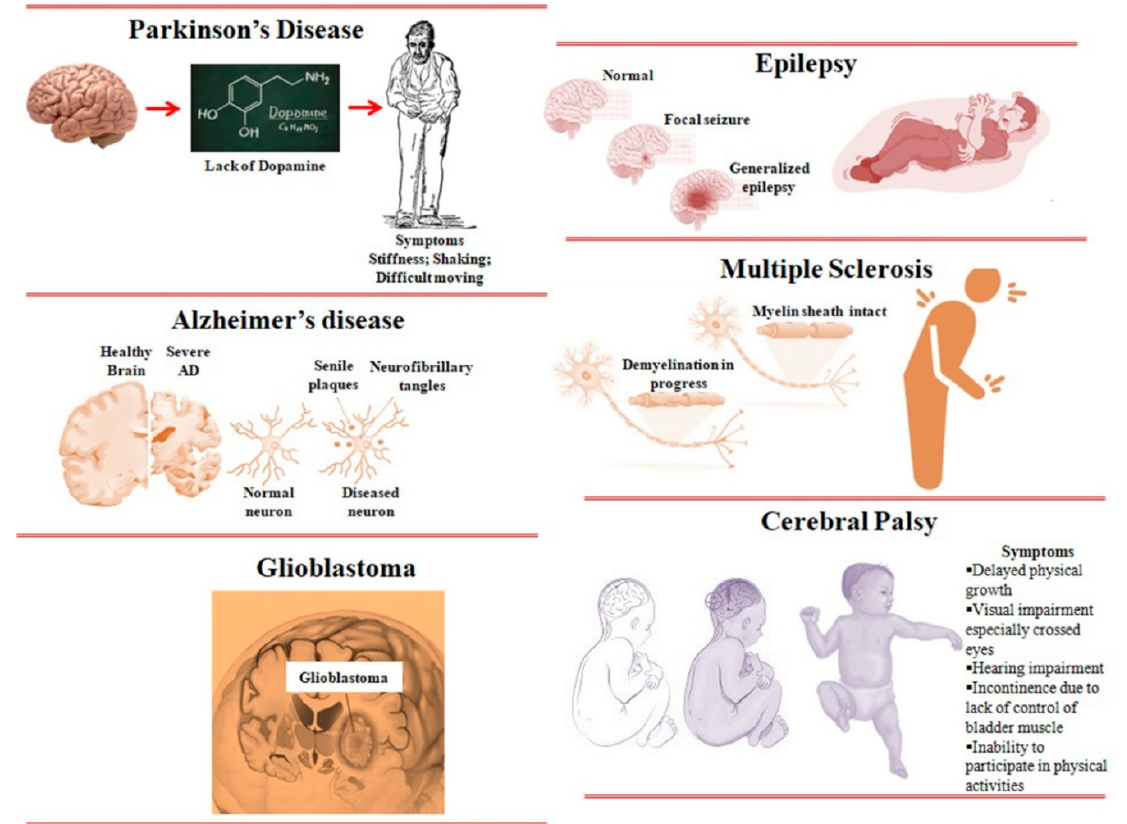
Figure 2. Important neurological disorders.